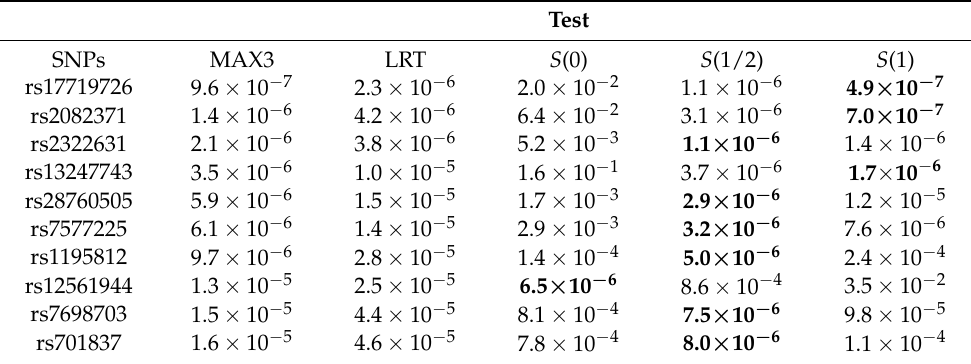
Table 4. Top ten SNPs with most significant p -values based on the CMAX3 test. For each SNP, the smallest p -value obtained by all methods is in